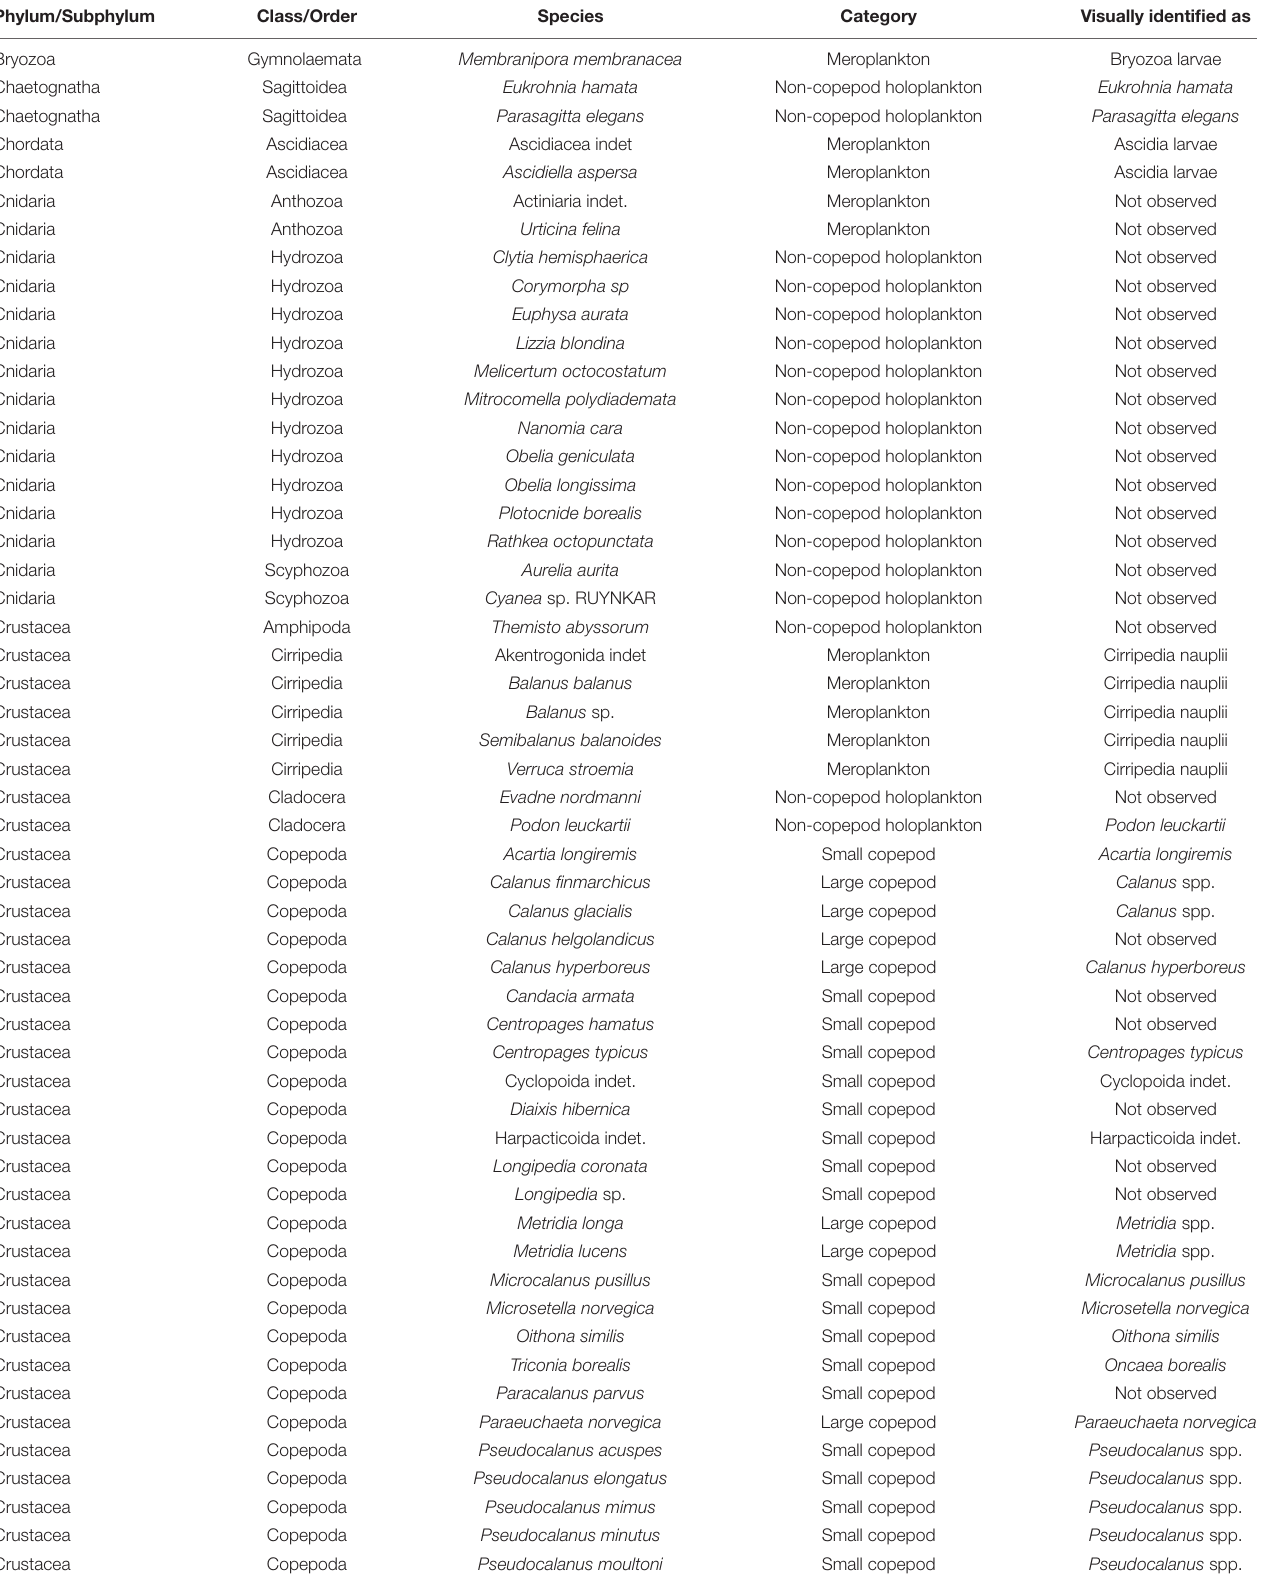
TABLE 2 | List of all species identified using metabarcoding, how they were categorized, and if or to what level they were identified in the visual